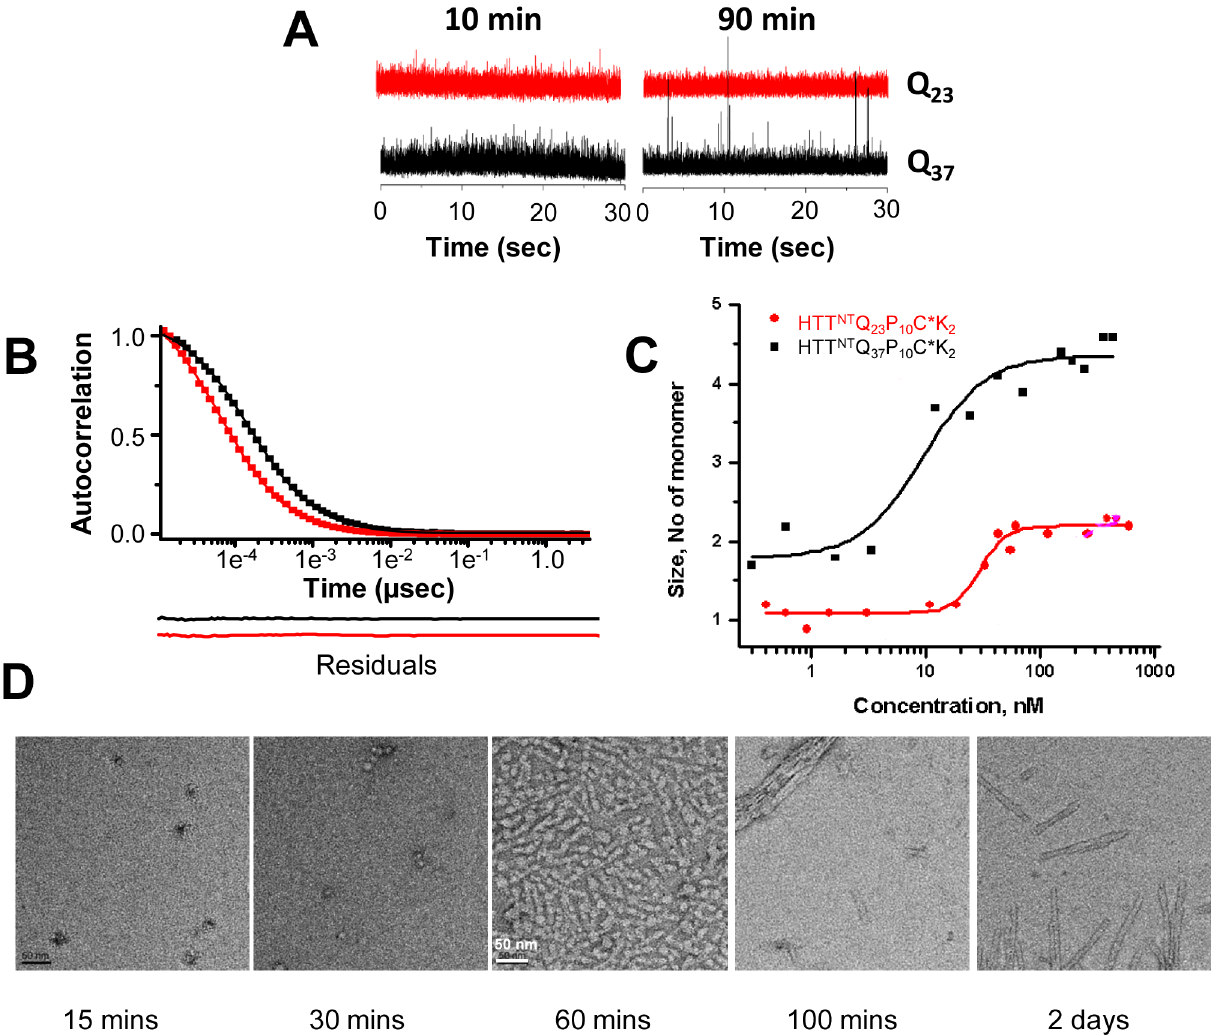
Fig 2. Self-assembly in PBS of chemically synthesized HTT exon1 analogs. A. Raw FCS time-dependent fluorescence fluctuations of HTT NT Q 23 P 10 C * K 2 (red) and HTT NT Q 37 P 10 C * K 2 (black). B. Autocorrelation functions for the 10 mins FCS data shown in A, with the data points as filled squares and solid lines representing the fits (see Materials and Methods) and the same color scheme as A. Lines below the graph show the residuals between the data points and the fit curve. C. Concentration dependence of molecular size estimated from diffusion times for HTT NT Q 37 P 10 C * K 2 ( ■ ) and HTT NT Q 23 P 10 C * K 2 ( ● ). D. EM detail of different time points from the PBS incubation of a mixture of 2.0 μ M HTT NT Q 37 P 10 K 2 . (More EM data is shown in S1